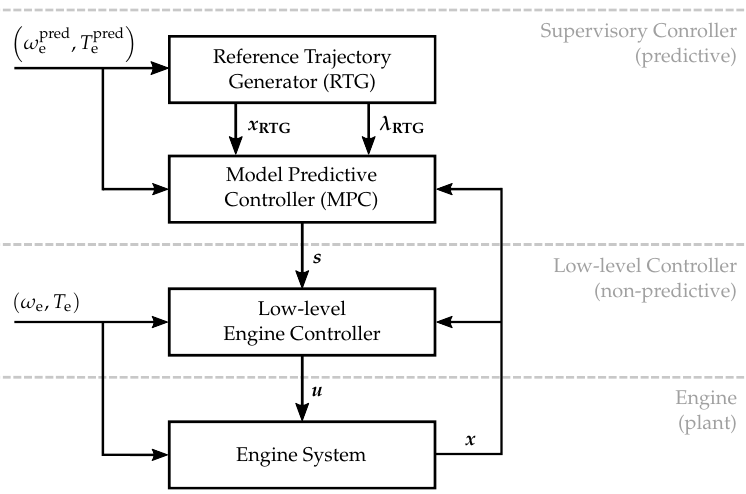
Figure 5. Controller structure consisting of a predictive supervisory controller and a non-predictive low-level engine